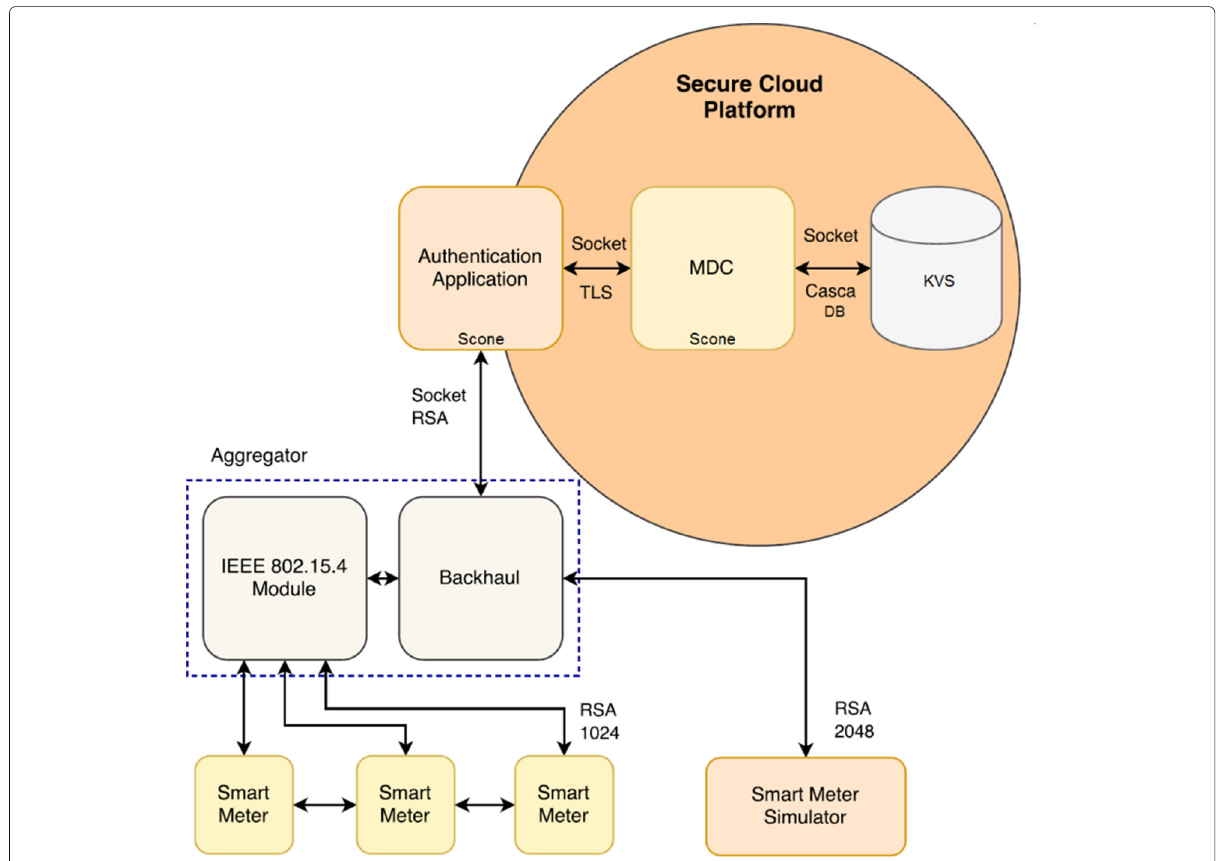
Fig. 1 Smart metering management implementation